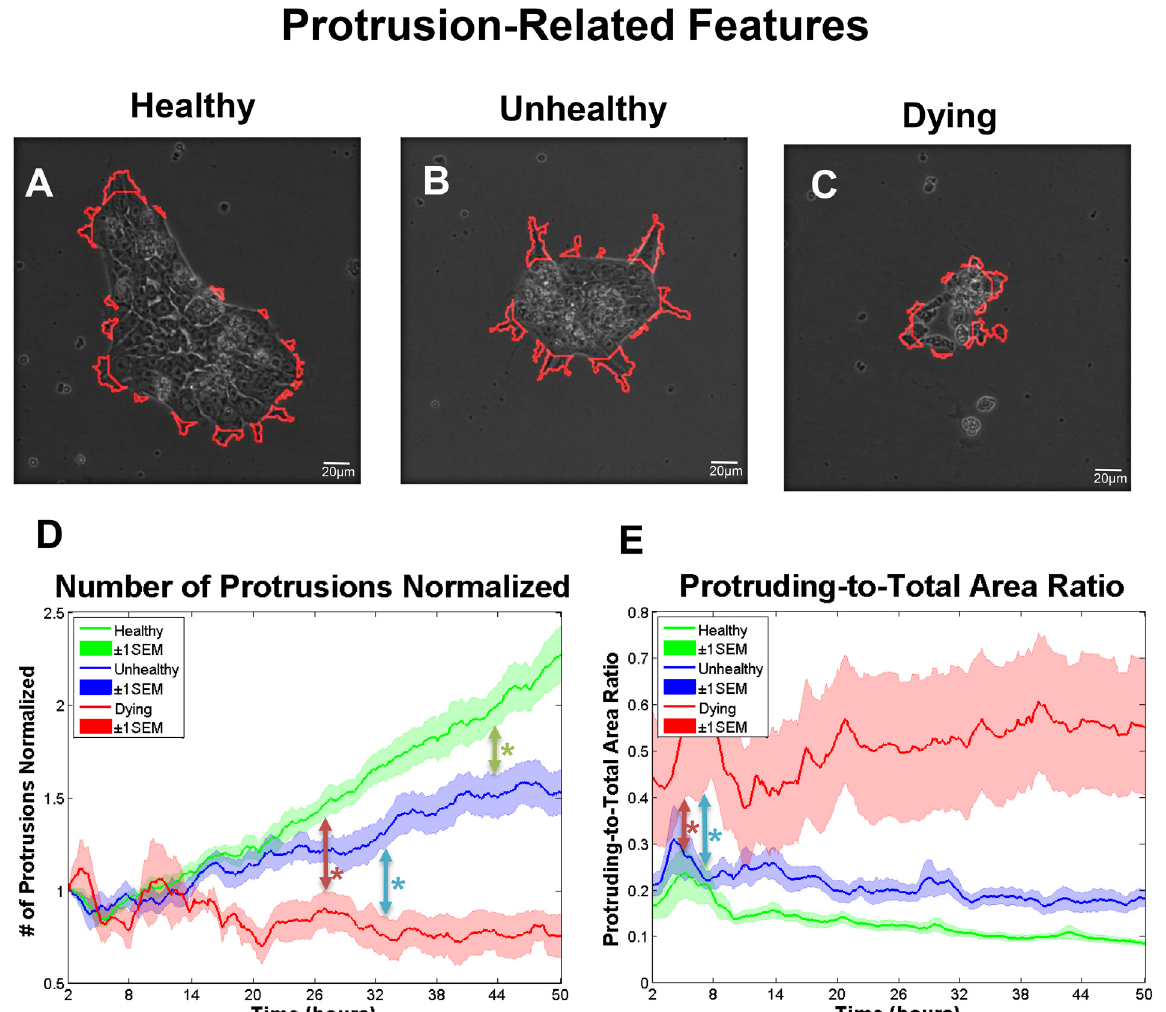
Fig 2. Surface protrusions on colonies can be used to study cell morphology and growth. (A) Segmentation of protrusions (red outline) for a healthy colony (A), unhealthy colony (B), and dying colony (C) at the last recorded time frame. (D) Number of protrusions over time normalized to the initial time point for healthy, unhealthy, and dying colonies. Colonies first became significantly different by 2-way ANOVA at 43 hours for healthy versus unhealthy groups (green arrow), at 33.3 hours for unhealthy versus dying groups (blue arrow), and at 27.1 hours for healthy versus dying group (red arrow). (E) Protruding-to- total area ratio for healthy, unhealthy, and dying colonies. Colonies first became significantly different by 2-way ANOVA at 6.8 hours for unhealthy versus dying groups (blue arrow), and at 4.8 hours for healthy versus dying groups (red arrow). Number of colonies per group = 16 healthy, 12 unhealthy, 6 dying. Data are plotted as means ± SEM for each group. Arrows indicate first values that differed significant from the control by 2-way ANOVA ( * = P <